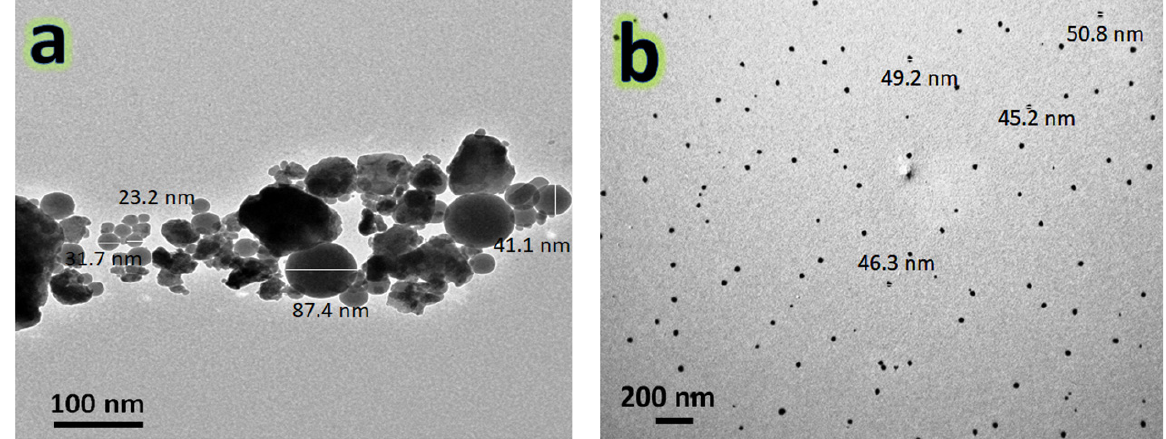
Figure 4. TEM micrographs of ( a ) NbC and ( b ) granite reinforcements.